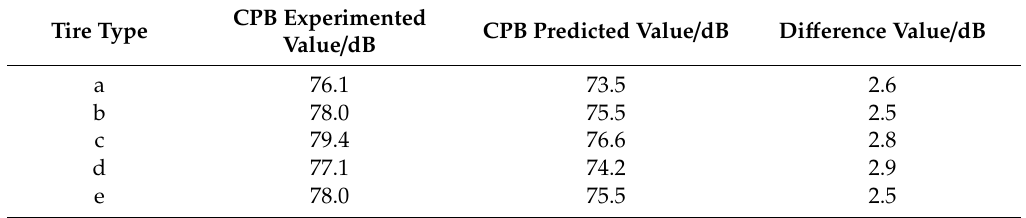
Table 7. The di ff erence value between the measured value and the predicted value of CPB tire noise when considering the shielding e ff ect of the vehicle body on noise